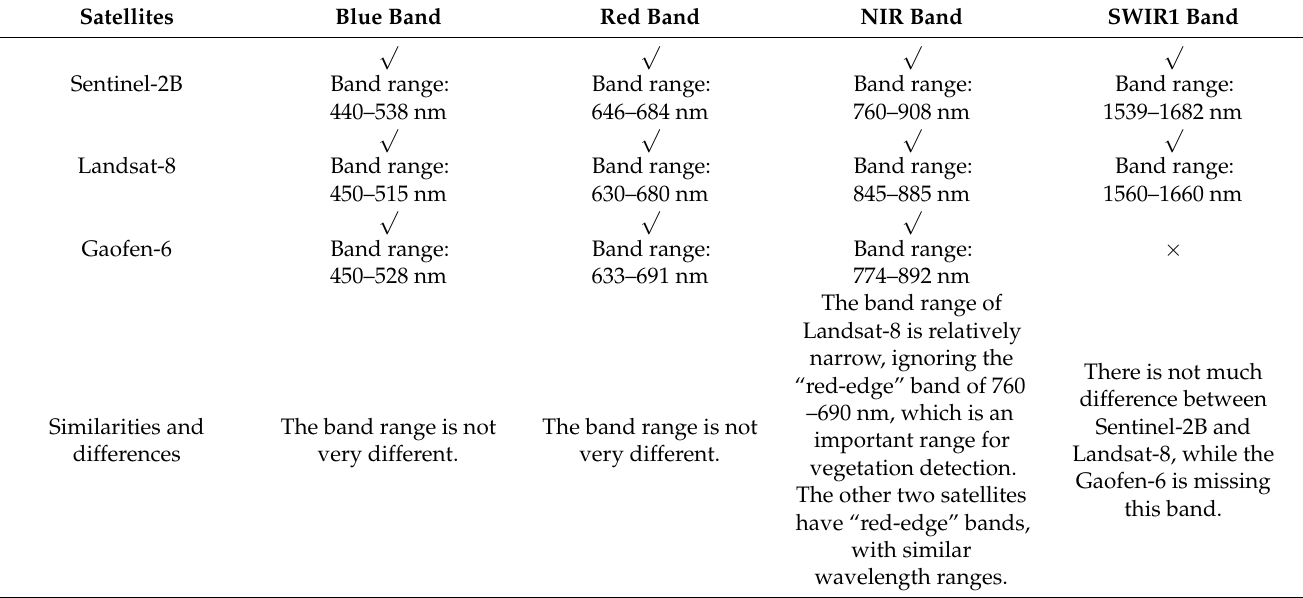
Table 4. Comparison of important bands on information extraction of rocky desertification.